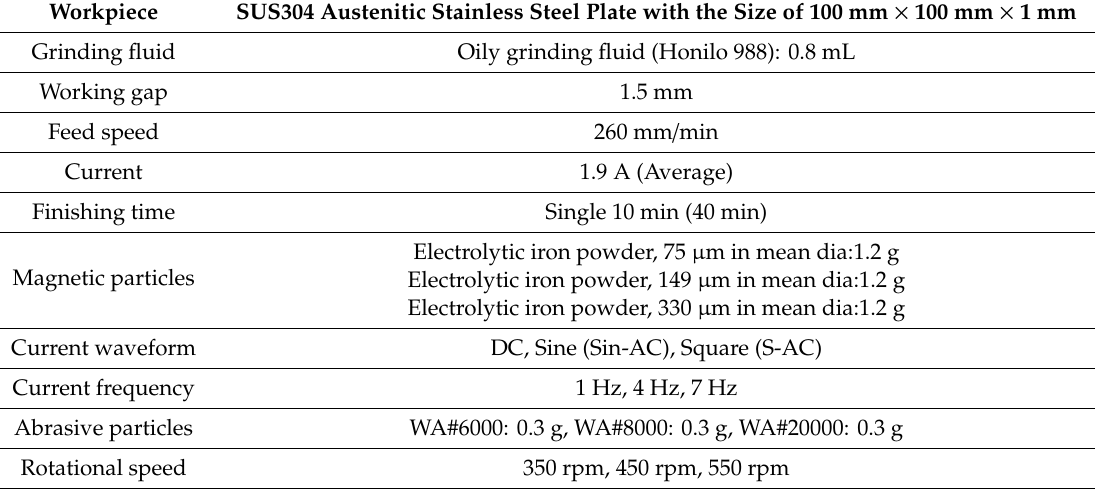
Table 1. Experimental conditions.